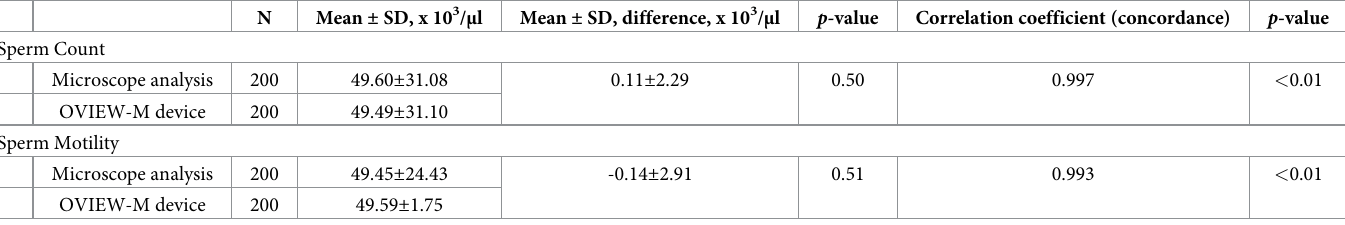
Table 1. Repeatability, precision, and correlation coefficients of motile sperm concentration and